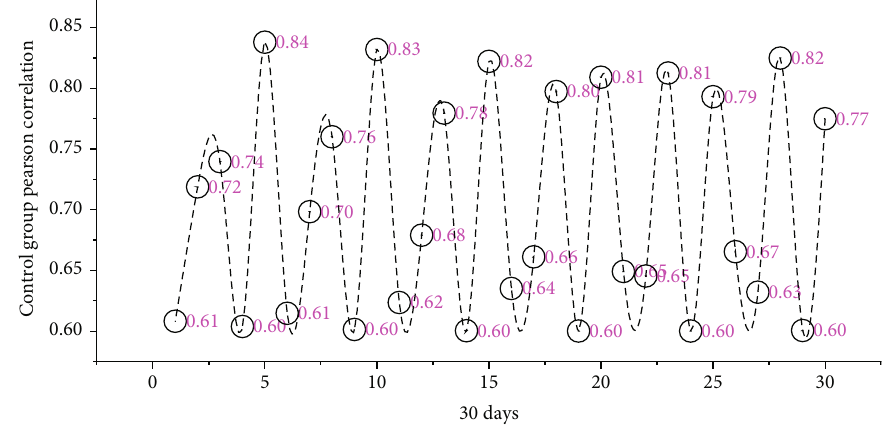
Figure 1: Pearson correlation analysis results of mental health and demographic data in the control group.